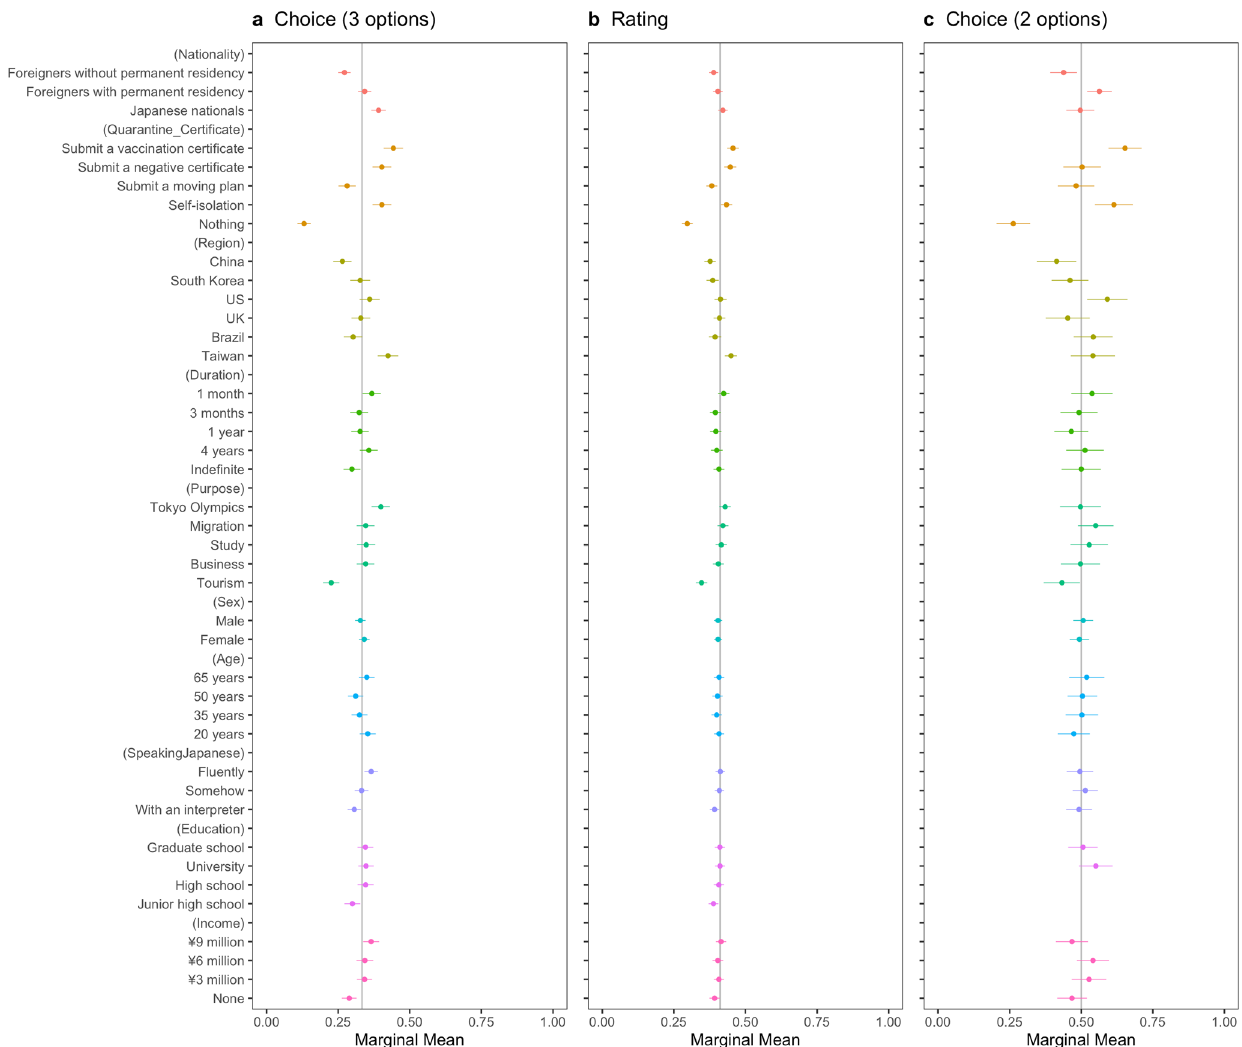
Fig. 1 Marginal means of the respondents ’ probability or rating of admitting travelers ’ entry with error bars of 95 % con fi dence intervals. The vertical lines show the random probability (0.33) for Panel a using the choice-based question (three options including “ Neither should be admitted ” ), the mean (0.41) for Panel b using the rating-based question, and the random probability (0.5) for Panel c using the choice-based question (two options).